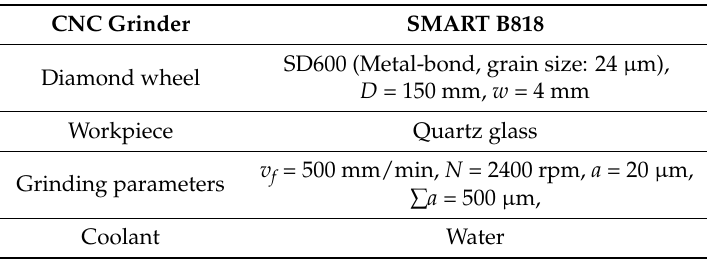
Table 2. Micro-grinding conditions of microgroove on workpiece substrate.